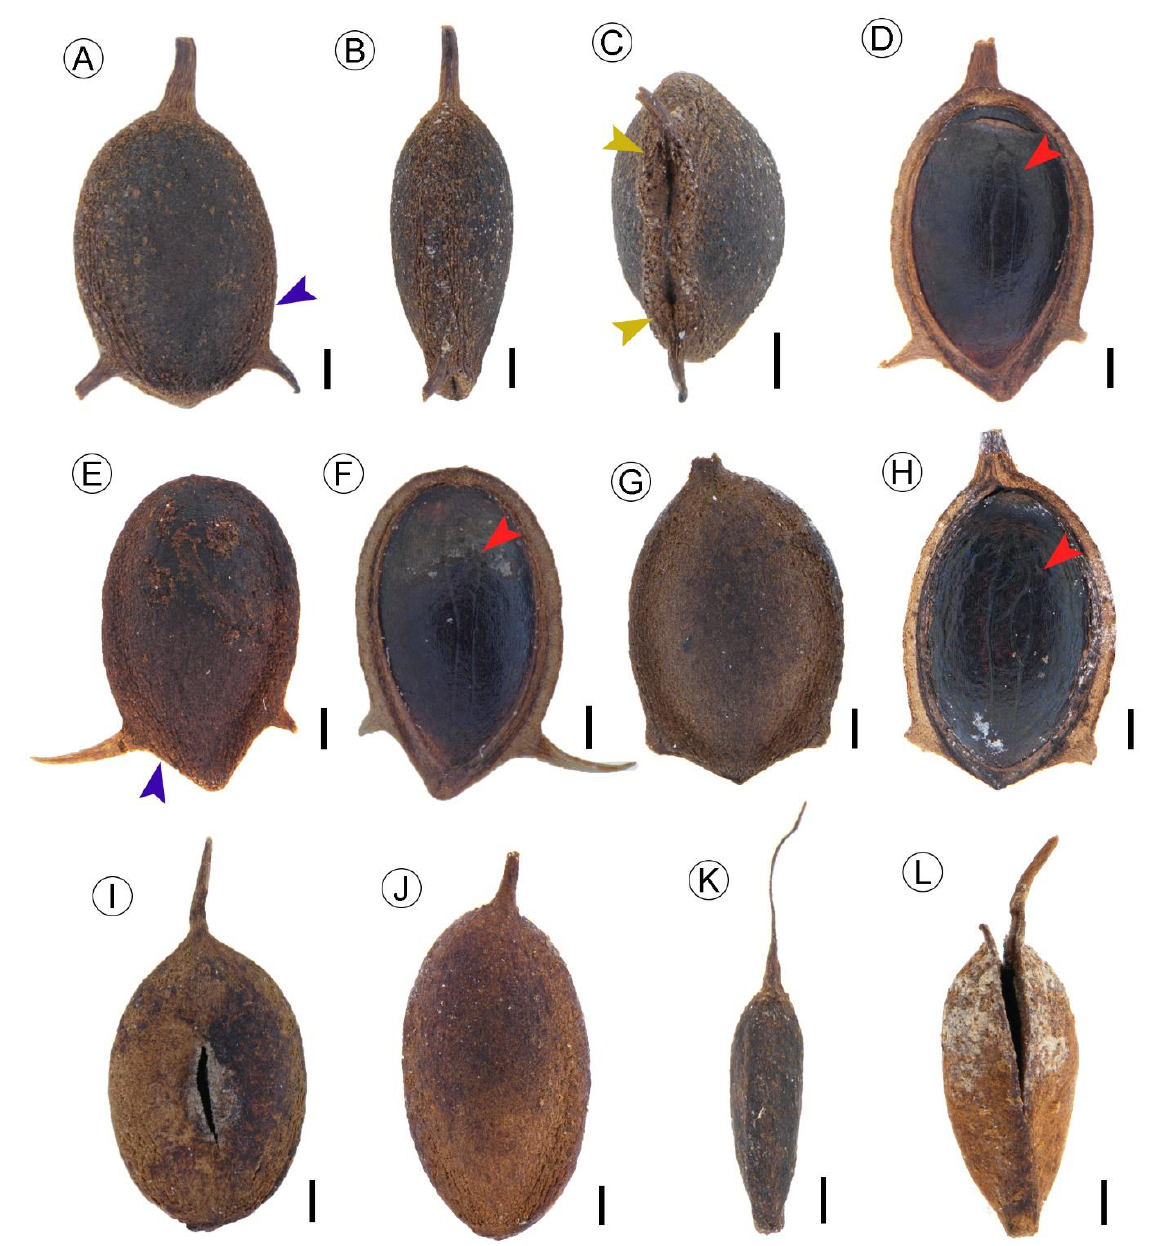
Figure 3. Fruit fossils of Ceratophyllum demersum L. from the Guiping Basin. ( A – C ) GP427. The blue arrow shows striated grooves near the edge, yellow arrows show holes at the base. ( D ) GP428a. Inner view of fruit, the red arrow shows the trace of a cotyledon. ( E , F ) GP428b. The blue arrow indicates the grooves on the surface, the red arrow shows the trace of a cotyledon. ( G ) GP429a Fruit outer surface, showing the location of spines. ( H ) GP429b. Inner view of fruit, red arrows indicate cotyledon traces. ( I ) GP430. Fruit with a stylar spine. ( J ) GP432. Fruit with an irregular tuberculate surface. ( K ) GP436. Lateral view of the fruit, showing a long stylar spine. ( L ) GP439. Lateral view of the dehiscent fruit. Scale Bars = 0.5 mm.